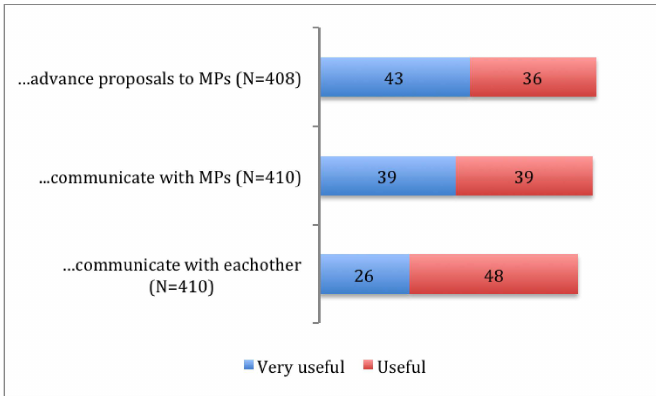
Figure 7. Respondents view about how useful it would be to add new communication tools to OP (%) (Author’s survey 2011)